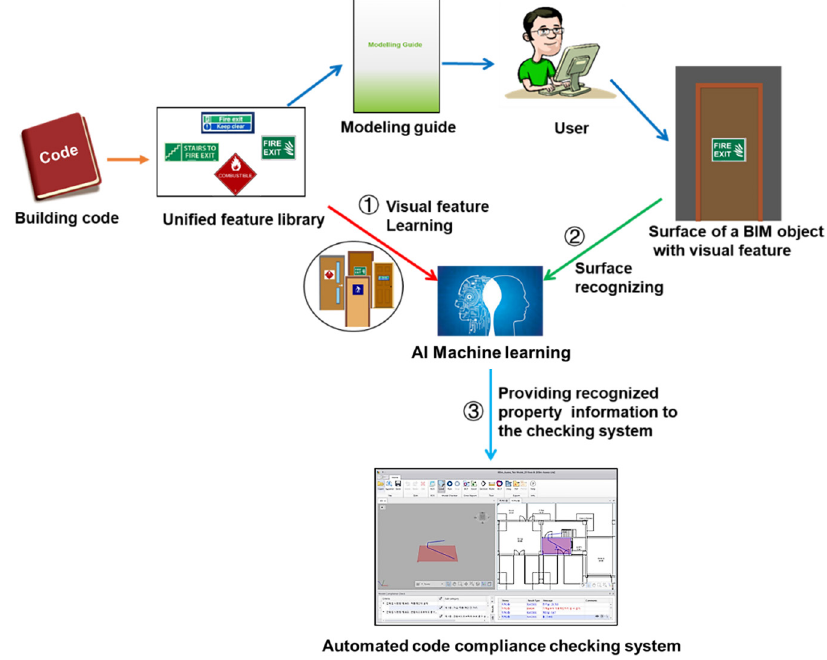
Figure 6. Automated code checking using visual feature recognition (Sun et al.,